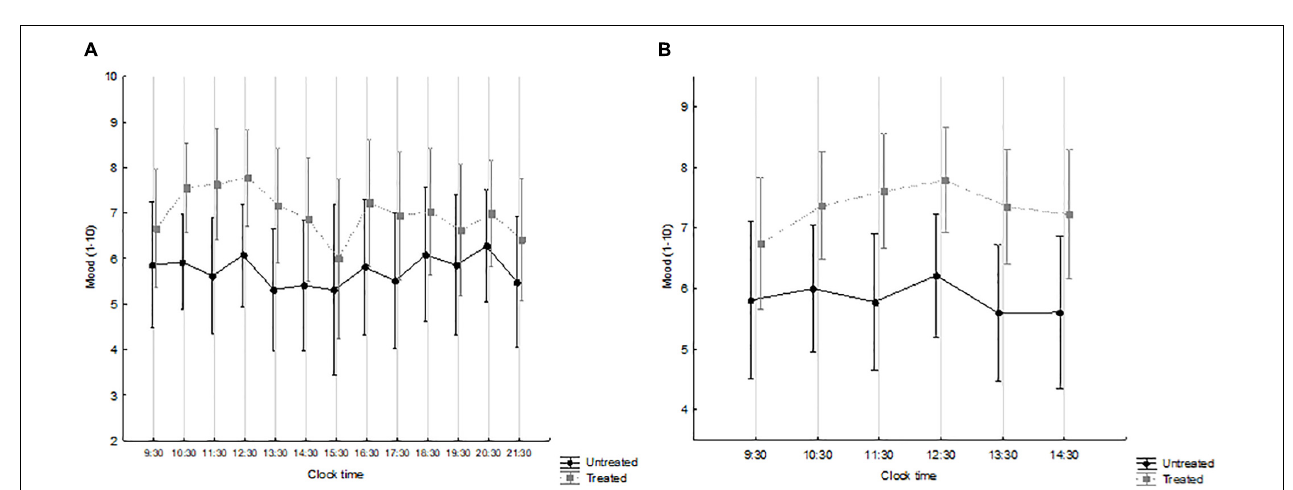
FIGURE 3 | Mood (1–10 visual-analogue scale), from 09:30 to 21:30 (A) and from 09:30 to 14:30 (B) in patients treated with Luminette light glasses plus short-wavelength filter glasses (gray squares and broken line) and untreated patients (black circles and full line). (A) Time: F = 1.583, p = 0.100; treatment: F = 2.887, p = 0.110; interaction time × treatment: F = 0.719, p = 0.732. treated n = 9; untreated n = 7. (B) Time: F = 1.773, p = 0.124; treatment: F = 5.692, p = 0.026; interaction time × treatment: F = 0.698, p = 0.626. treated n = 14; untreated n =